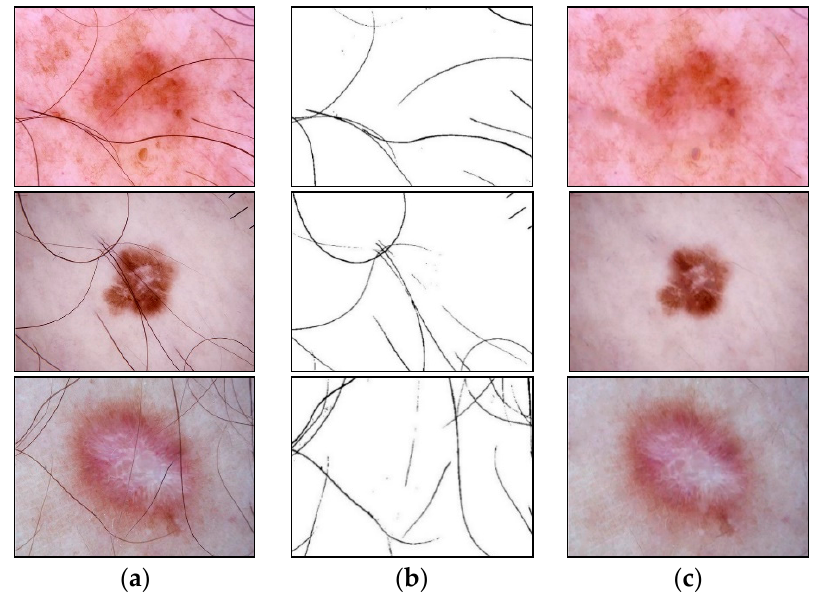
Figure 9. Examples of identification and cleaning of hair structures from dermatoscopic images of pigmented skin lesions using the proposed method: ( a ) original dermatoscopic image; ( b ) the result of extracting hair in the image (inverted image); ( c ) dermatoscopic image cleared of hair structures. Scale bar or magnification.